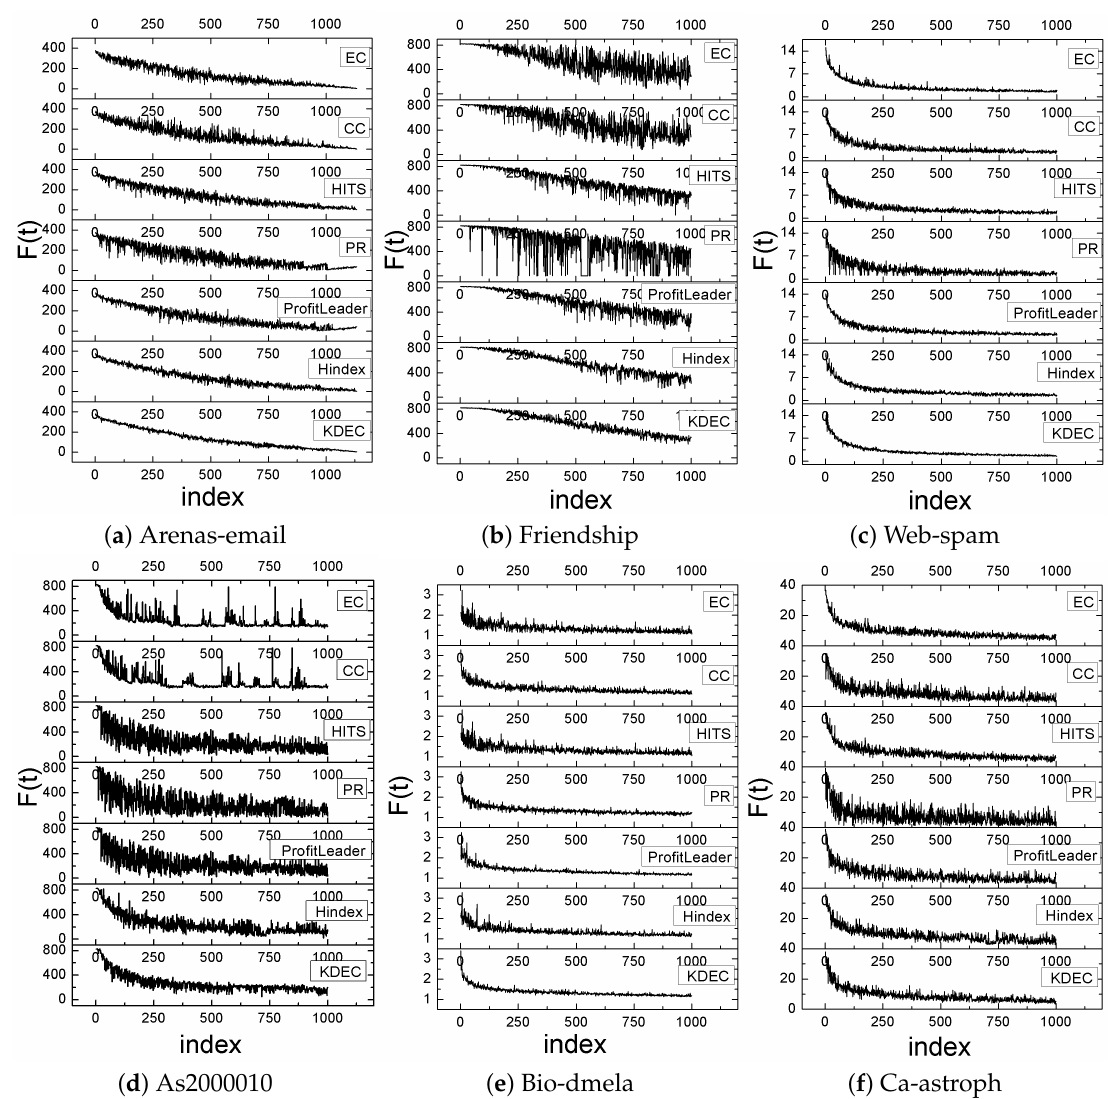
Figure 2. Infection effect of influential nodes identified by each comparison